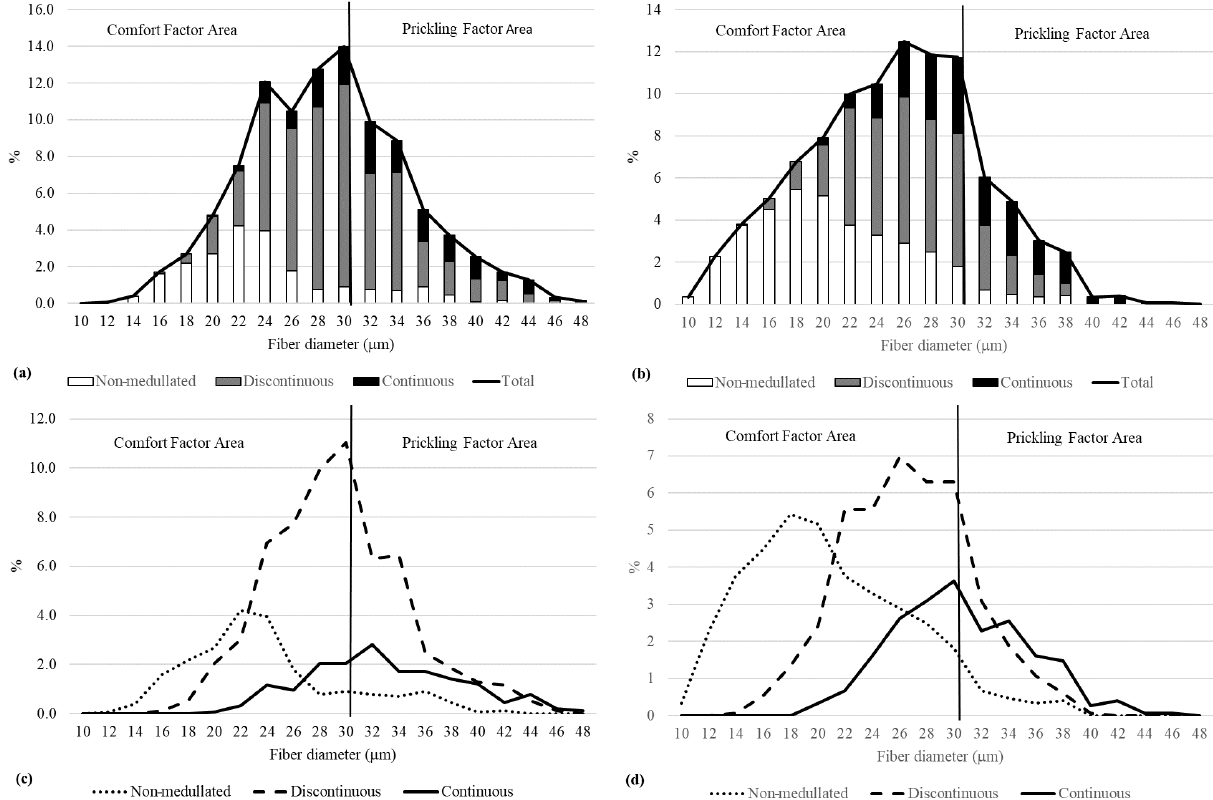
Figure 5. The fiber category distribution within diameter classes in wool from male (a) and female (b) alpacas, and the distribution of each fiber category in male (c) and female (d)